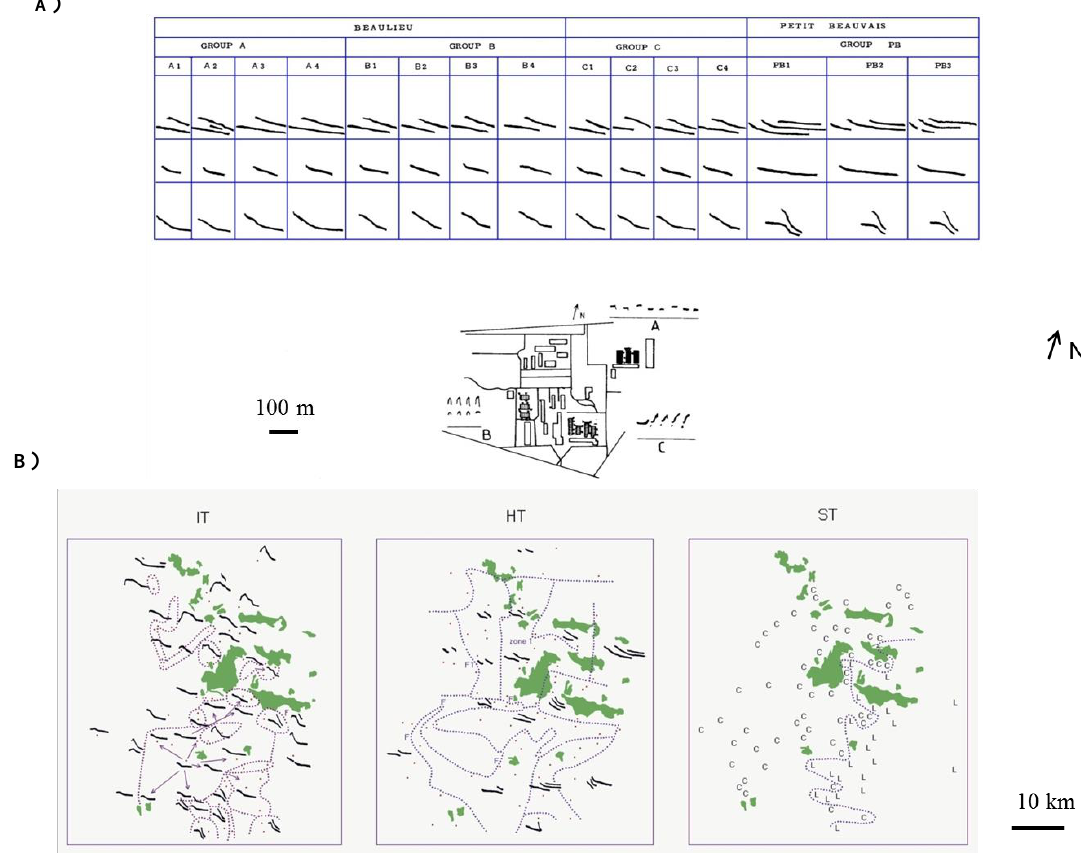
Figure 3. Complex dialectal system in the European starling observed in Rennes area. A) Comparison of class I themes (Inflection, Harmonic and simple themes) between colonies either on the same site (groups A, B, and C, 200 m apart) or further apart (15 km, Group PB). A map of site 1 (Rennes Campus University). The rectangles correspond to buildings where the nests are present (hatched or dark rectangles). The spectrograms correspond to the variant of the rhythmic theme sung by all members of the colonies considered, B) each map represents dialectal boundaries for the different types of class 1 whistles. Note the different level of variation for each type. IT, Inflection Theme, HT, Harmonic Theme, ST, Simple Theme and RT, Rhythmic Theme. In maps, dialectal boundaries correspond to dotted lines. The hatched areas correspond to forests. C, L, short versus long variant of ST (Hausberger,